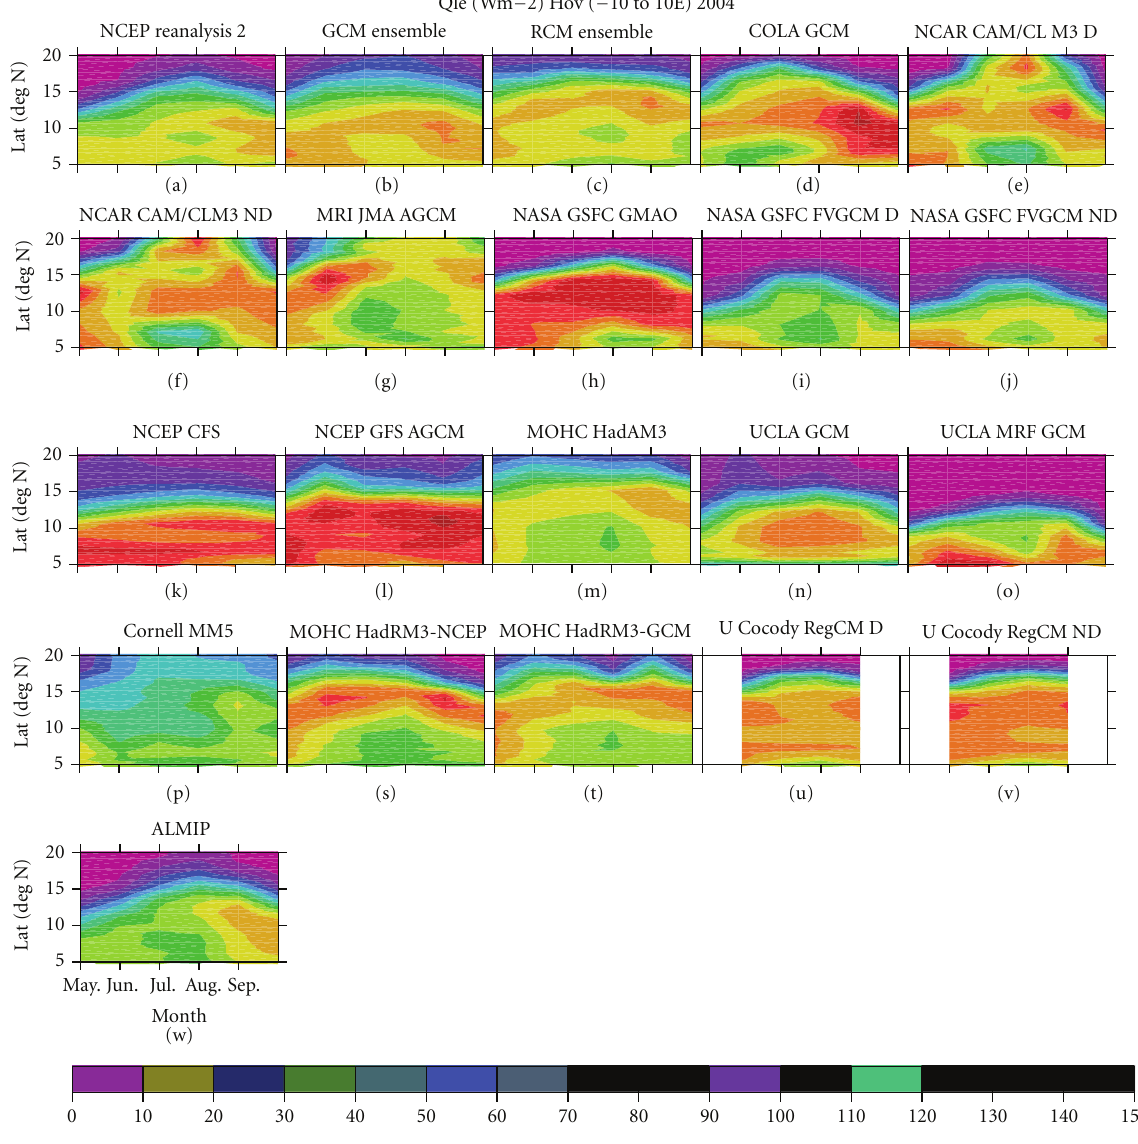
Figure 2: The WAMME latent heat flux area averaged from June through September (JJAS) for 2004 [33]. The corresponding ALMIP field is shown in panel